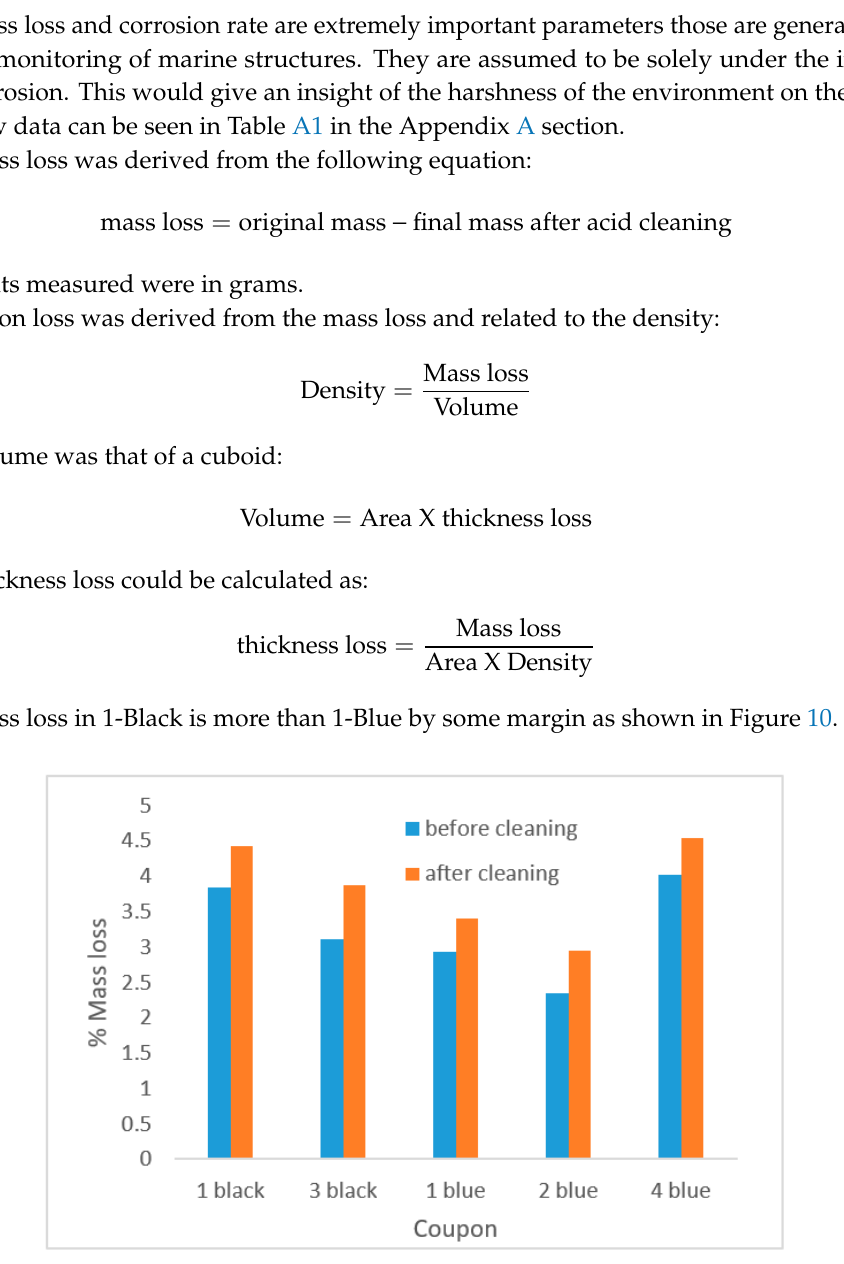
Figure 10. Mass loss (wt. %) of coupons due to corrosion, (before and after cleaning).